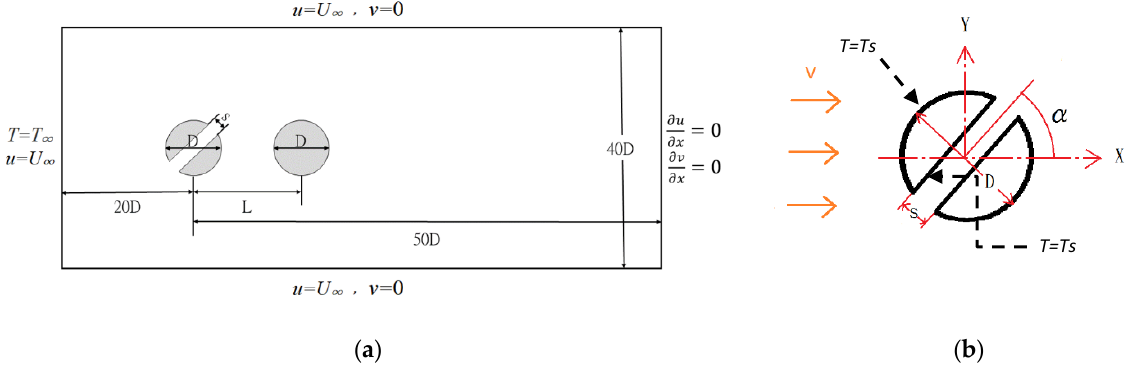
Figure 2. The computational domain and boundary conditions: ( a ) domain and ( b ) model of cylinder with a slit.